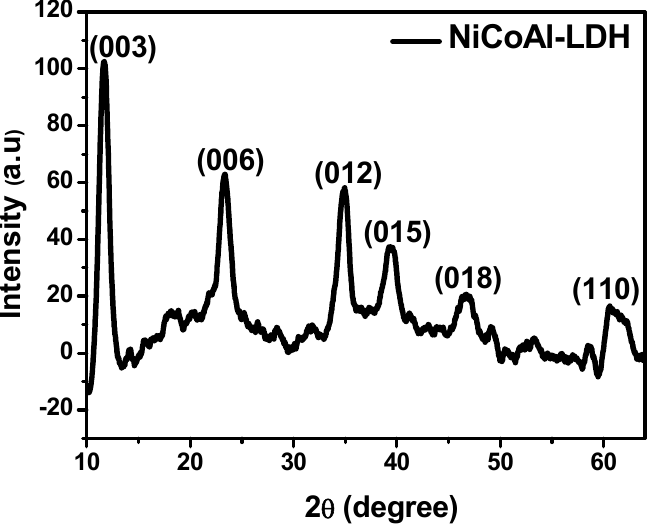
Figure 1. XRD patterns of the as-synthesized LDH used as electrode active material.